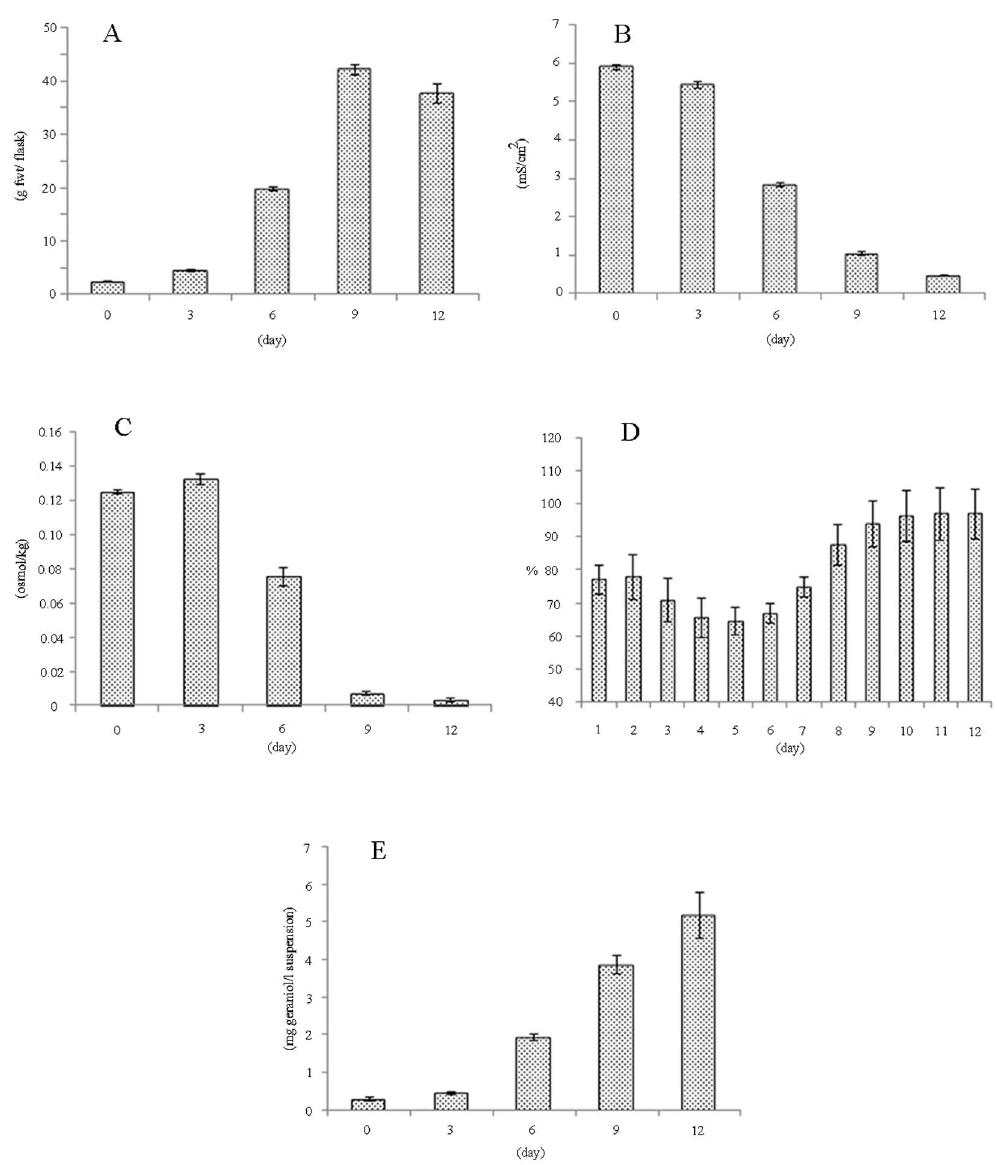
Figure 6. Time-course dynamics. Cultivation conditions: 250 ml shaking flasks; 20 g/l sucrose; 50% filling volume; 5.6% (w/v) inoculum size; 35.62 ( m mol/cm 2 /s) light; 2 mM triacetyl- b -cyclodextrin and 180 rpm shaking frequency. (A) Plant cell growth. (B) Electroconductivity. (C) Osmolality. (D) Dissolved oxygen. (E) Geraniol yield.